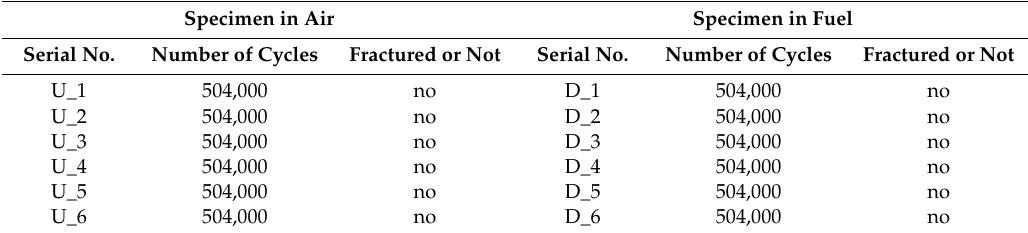
Table 5. Test results at an acceleration of 5.18